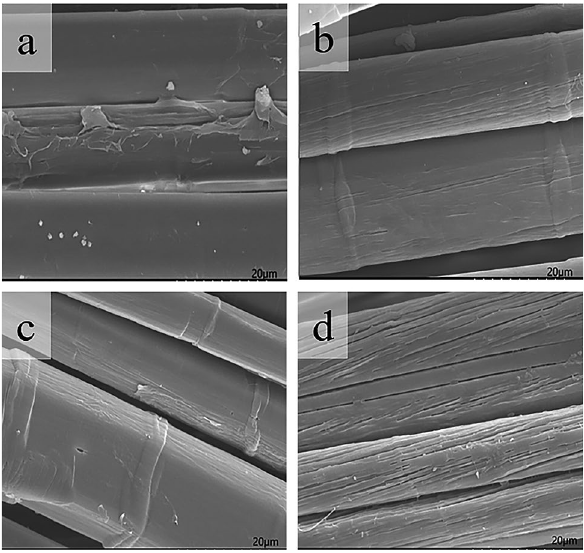
Figure 9. SEM photos of the bleached samples with different dosages of the synthesized OBS. ( a ) 2 g/L OBS; ( b ) 4 g/L OBS; ( c ) 6 g/L OBS; ( d ) 8 g/L